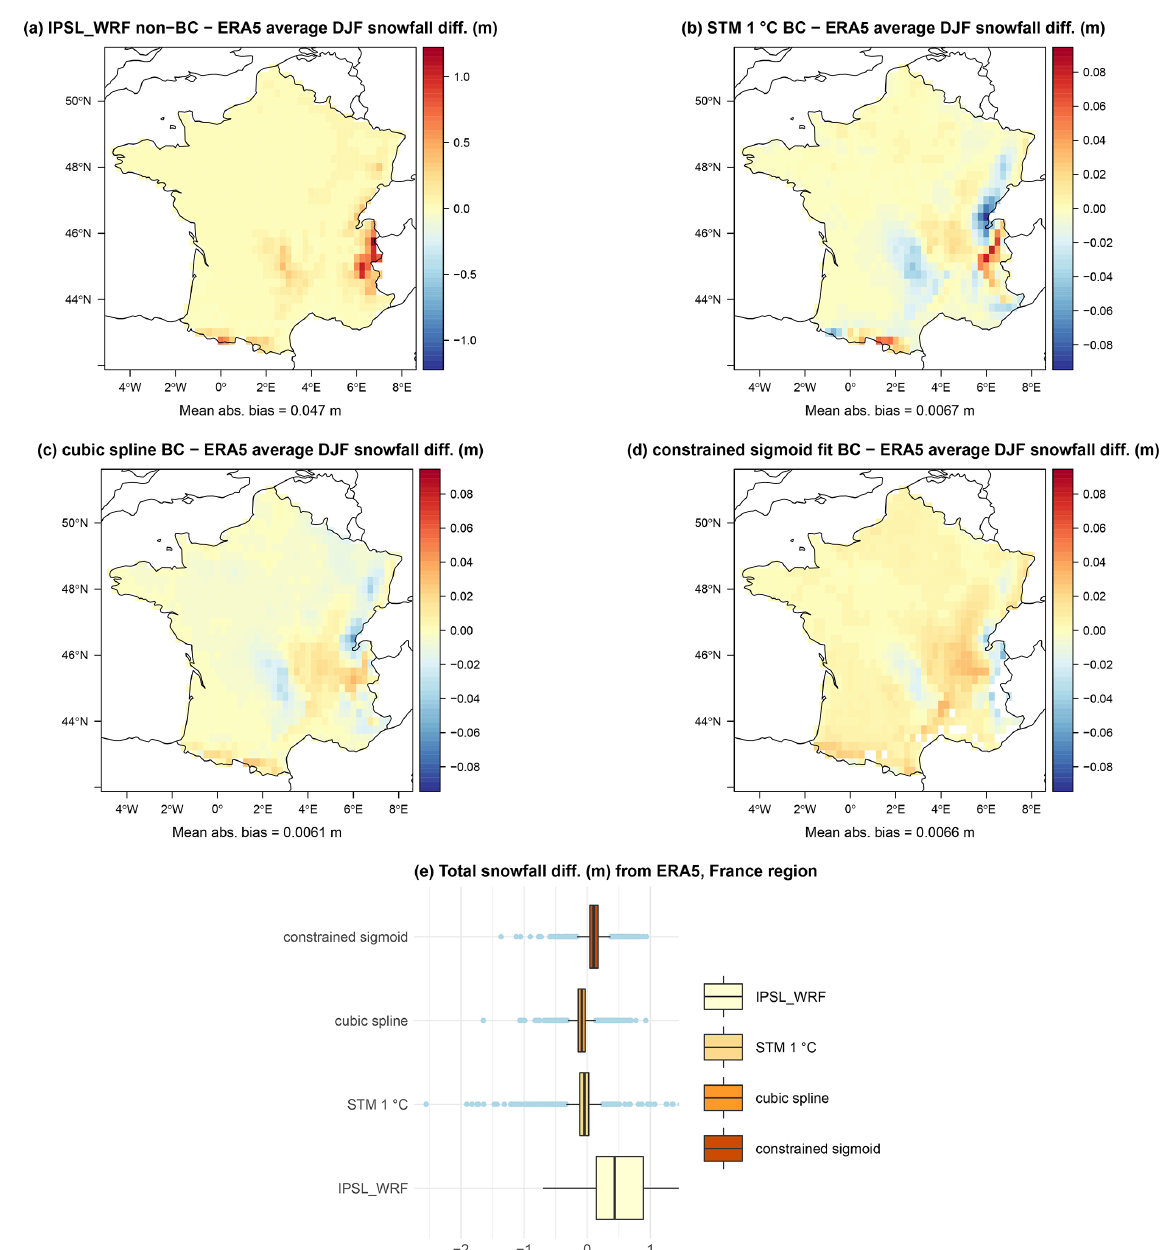
Figure 12. Maps of average 1979–2005 DJF snow differences over France between raw IPSL_WRF (a) , STM (b) , cubic spline regression (c) , sigmoid fit (d) bias correction, and ERA5. Corresponding summary box plots are shown in panel (e)